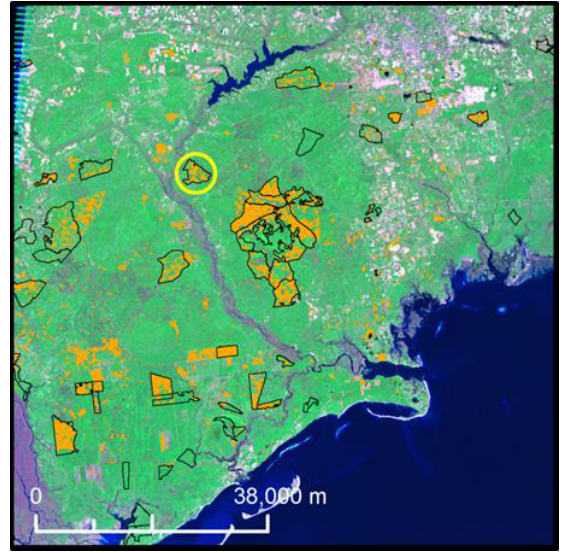
Figure 1. Landsat-derived burned area polygons (orange) and their proximity to MTBS-derived perimeters (black). Yellow circle denotes perimeter shown in Figure 3.